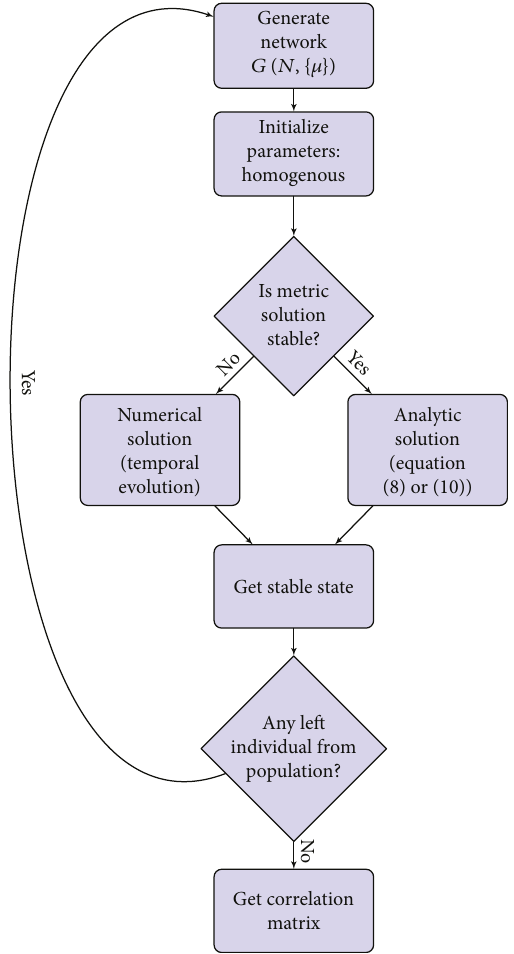
Figure 7: Flowchart to generate correlation matrix of variables out of a population of